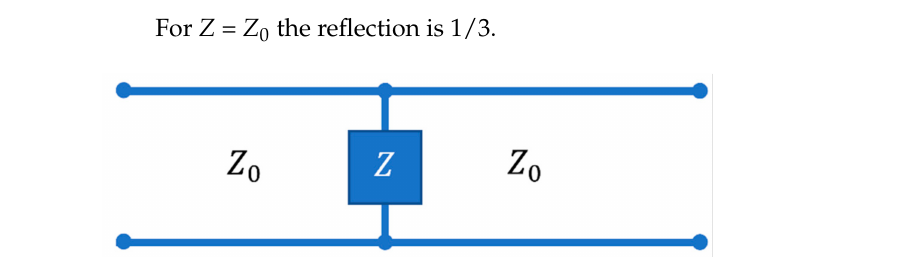
Figure A2. Schematic model of transmission line with pixel with impedance Z. (note Z 0 is the impedance of the air or vacuum).